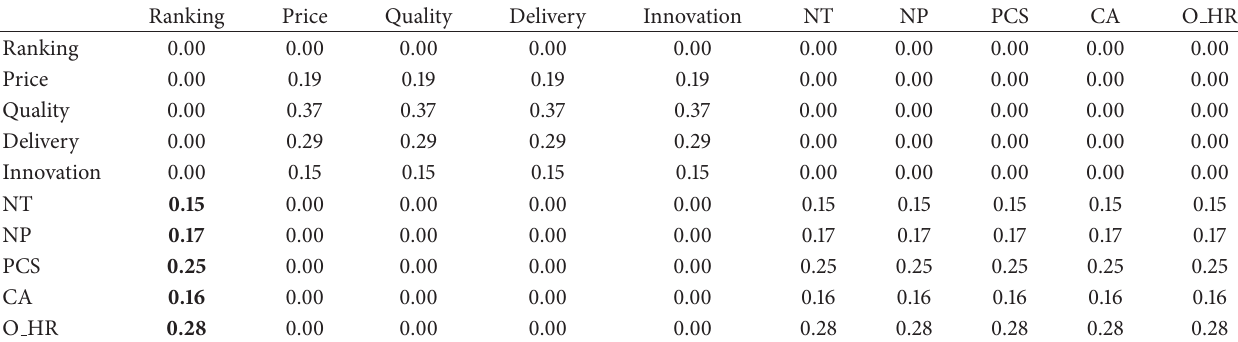
Table 10: Matrix limit corresponding to the decisions of decision agent 1.